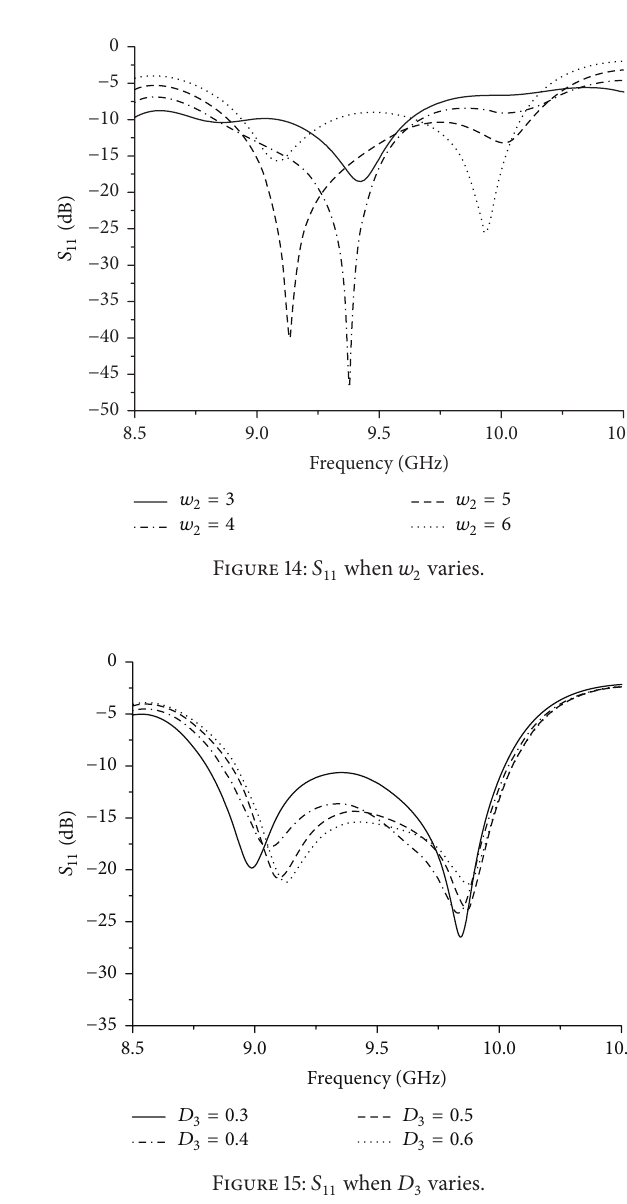
Figure 13: 𝑆 11 when 𝑡 2 varies.